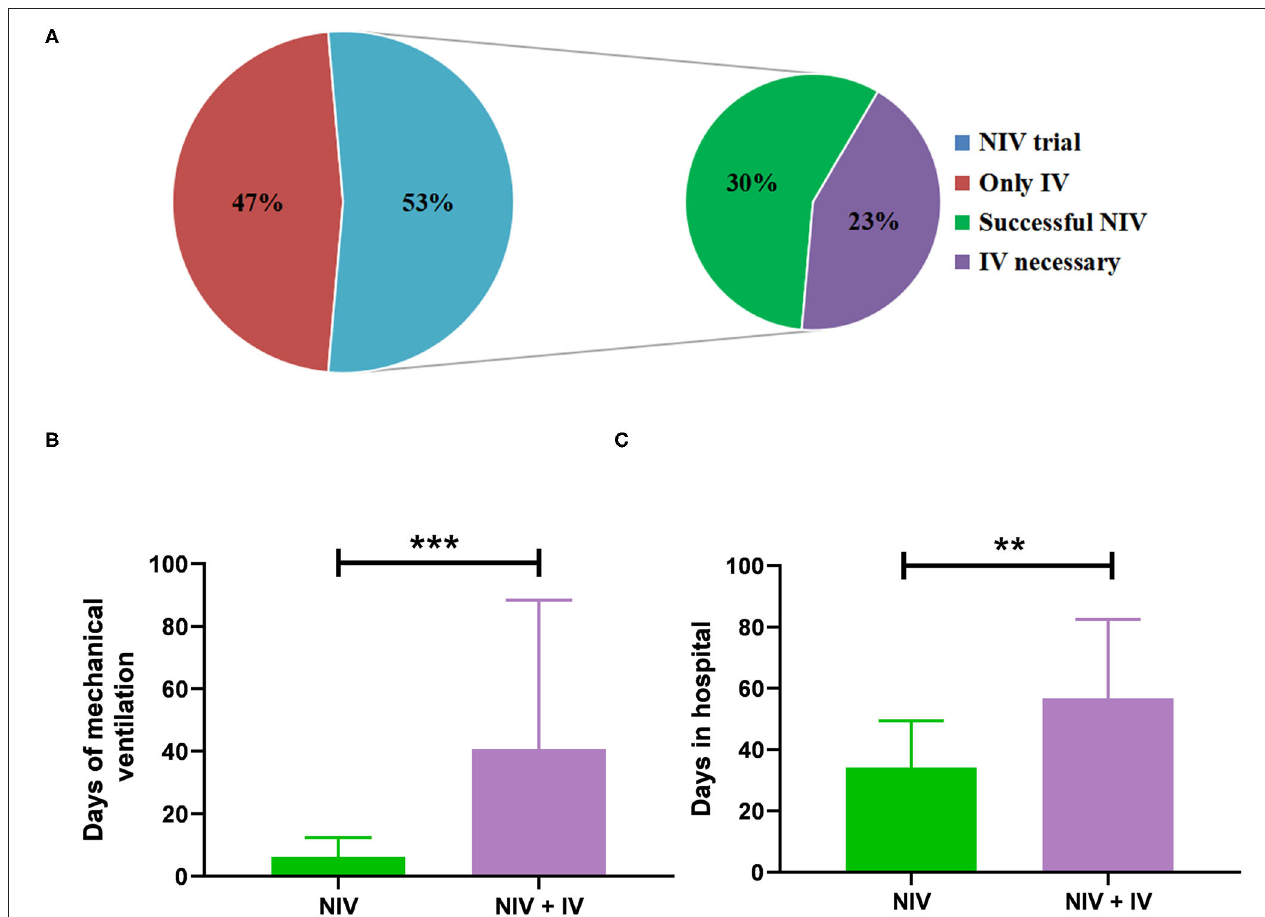
FIGURE 2 | Administration of mechanical ventilation (MV). (A) The percentage of patients where non-invasive ventilation (NIV) was attempted before invasive ventilation ( n = 32 out of 60) and the percentage of successful NIV trials and the percentage of NIV failure. Days of MV (B) and days of stay in the hospital (C) of patients treated with NIV alone ( n = 18) as compared to patients treated with NIV and invasive ventilation ( n = 14). Bars show mean ± SD. *** p < 0.001, ** p < 0.01 (Mann-Whitney U